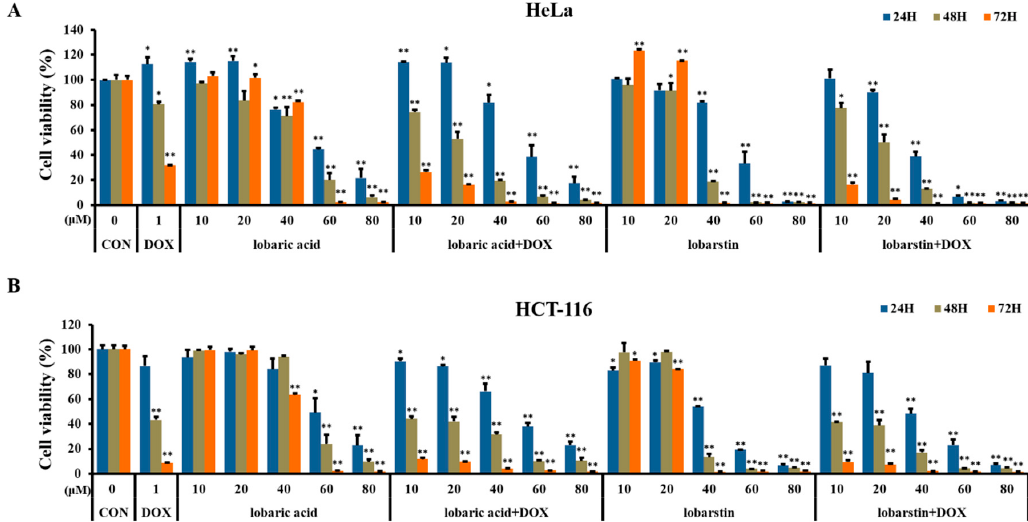
Figure 2. Effect of lobaric acid and lobarstin on the growth of ( A ) HeLa and ( B ) HCT116 cells. The cells were treated with the indicated concentrations of lobaric acid and lobarstin for 24, 48, or 72 h. Cell growth was measured with a cell proliferation assay. Data are presented as percentage of control and are the mean ± SEM ( n = 3); * p < 0.05 and ** p < 0.01 compared to the control.